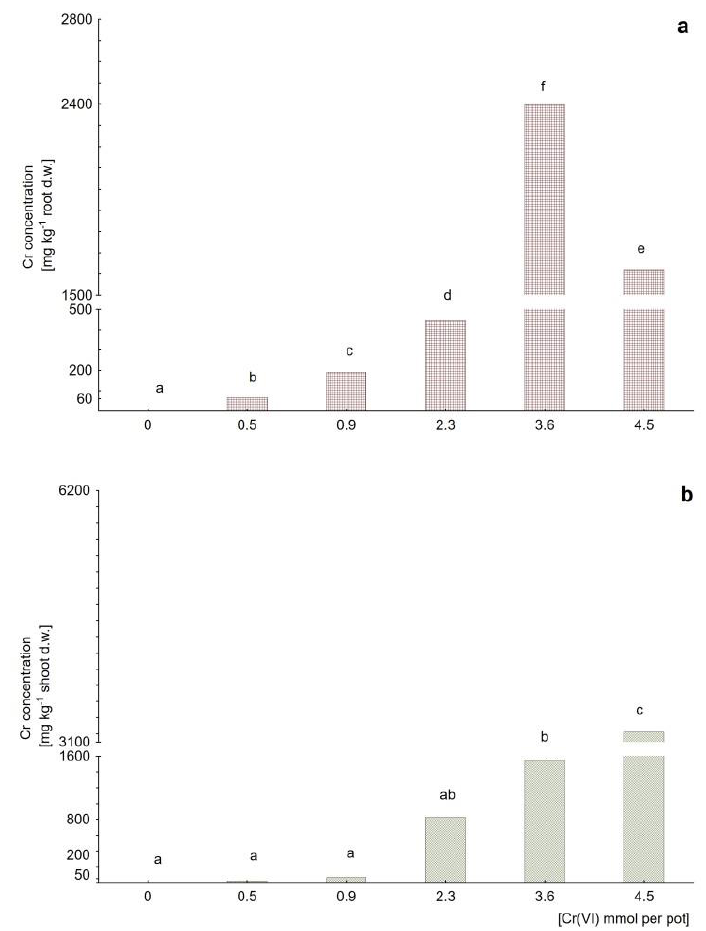
Figure 4. Chromium content in ( a ) roots and ( b ) shoots of Mesembryanthemum crystallinum plants subjected to Cr(VI) applied as potassium chromate, K 2 CrO 4 , at the doses of 0.5, 0.9, 2.3, 3.6 and 4.5 mmol per pot (untreated control at a dose 0). Different letters above the bars indicate statistically significant differences at p ≤ 0.05.